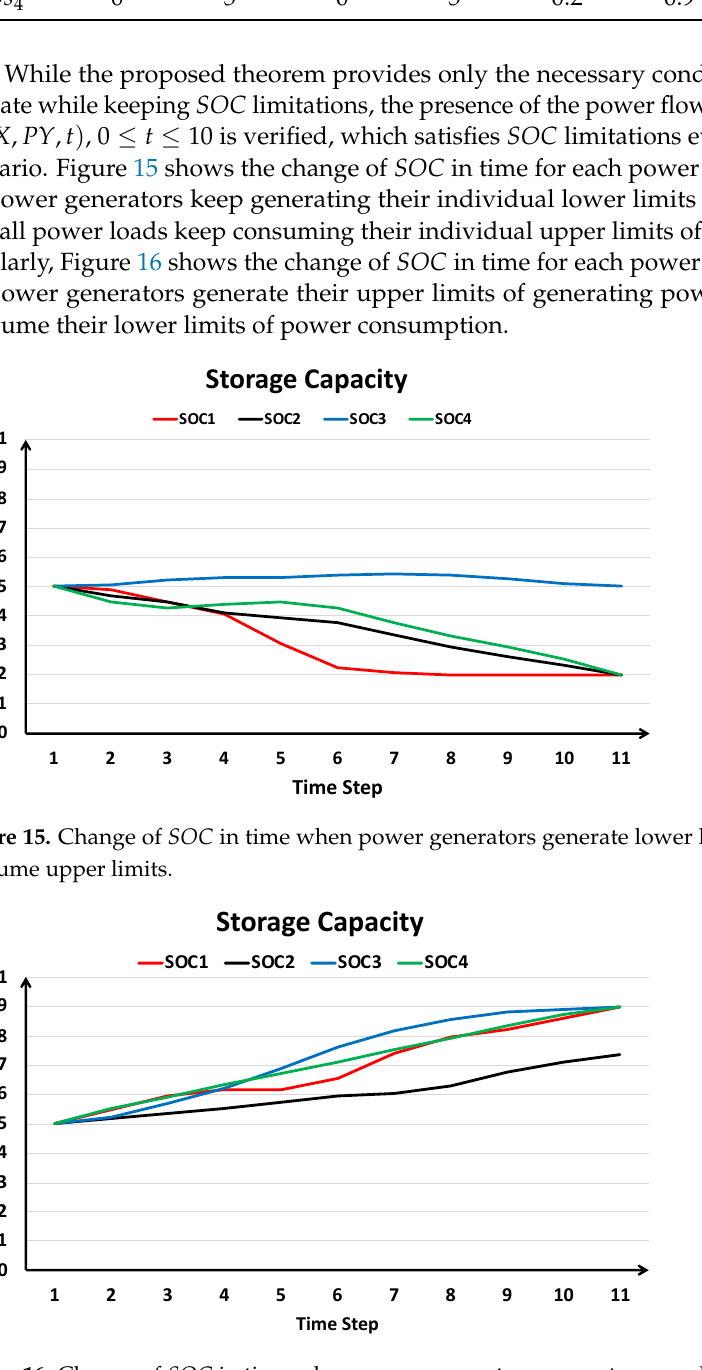
Figure 16. Change of SOC in time when power generators generate upper limits and power loads consume lower